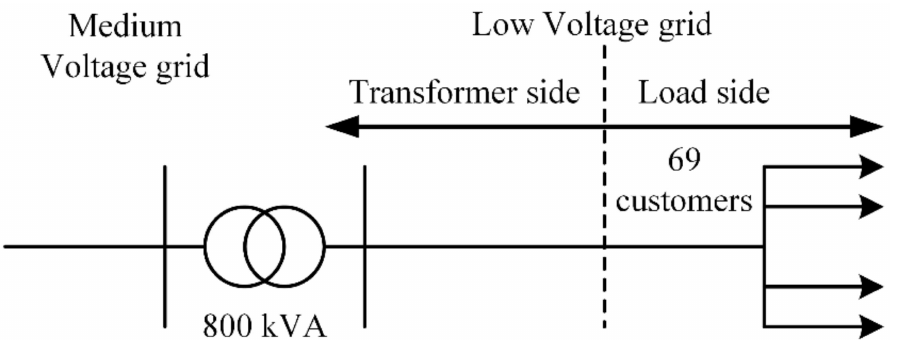
Figure 1. The one-line diagram of the LV feeder under